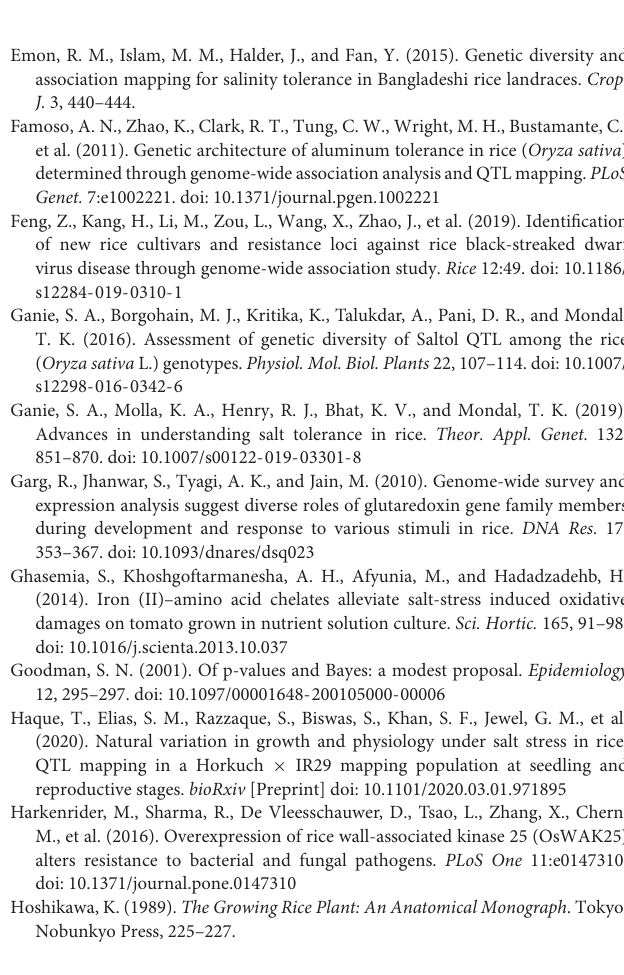
Supplementary Figure 1 | Trait distribution of the accessions on each salt tolerance (ST)-related index at seedling stage. The boxes with 3 lines represent first quartile, median and third quartile. Plotlines extending from the boxes (whiskers) indicate variability outside the upper and lower quartiles. Each point represents a variety, and the black points represent outliers. Supplementary Figure 2 | Trait distribution of the accessions on each ST related index at reproductive stage.The boxes with 3 lines represent first quartile, median